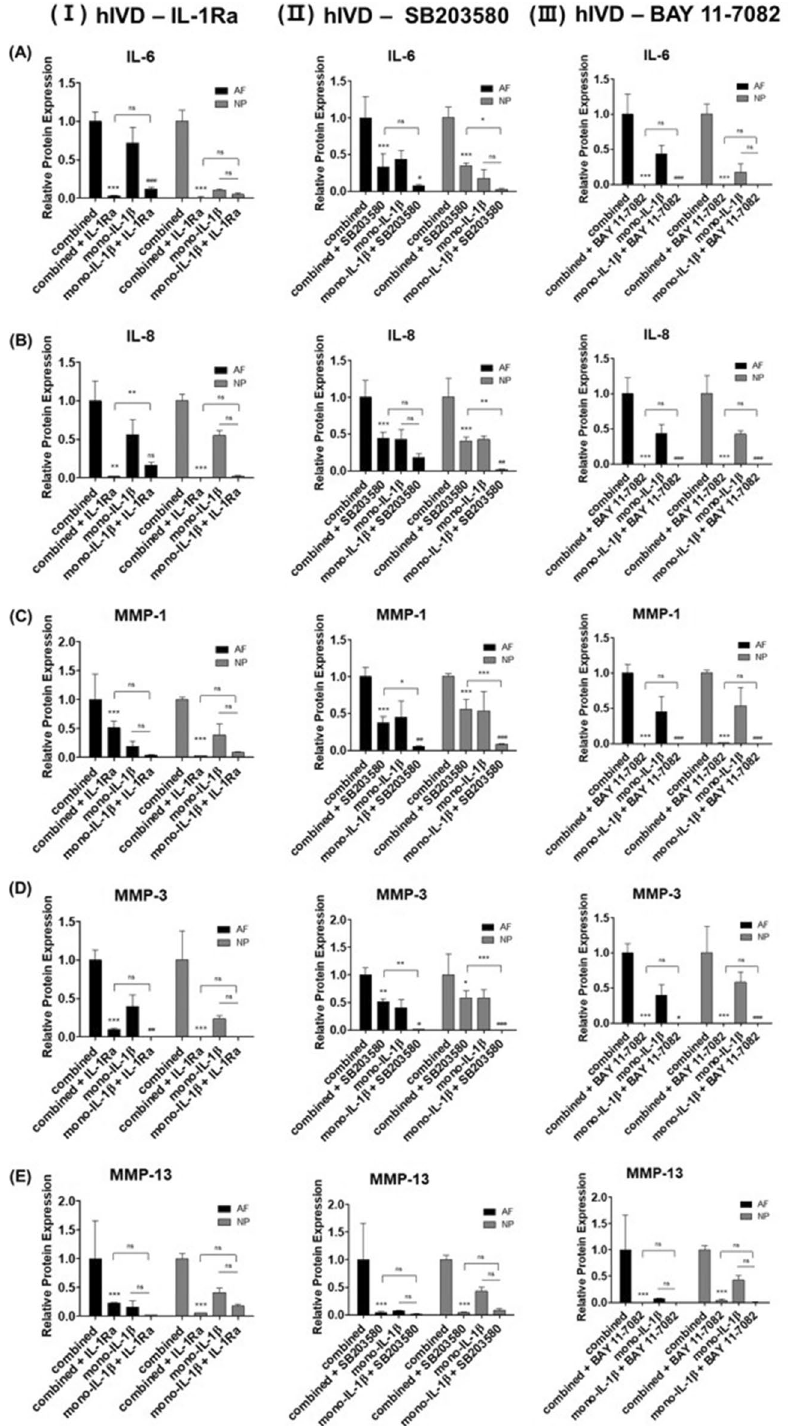
Figure 6. Combined-hResistin and IL-1β stimulation induced changes in the expression of secreted inflammatory cytokines and ECM catabolic enzymes (*p < 0.05, **p < 0.01, and ***p < 0.001 compared to the combined stimulation group, # p < 0.05, ## p < 0.01, and ### p < 0.001, compared to the mono-IL1β stimulation group, n = 5/group) ( A ) IL-6, ( B ) IL-8, ( C ) MMP-1, ( D ) MMP-3, and ( E ) MMP-13 in hAF and hNP cells, followed by subsequent stimulation with IL-1, p38 MAPK, and p65 NF-κB-specific inhibitors, which are (I) IL-1Ra, (II) SB203580, and (III) BAY